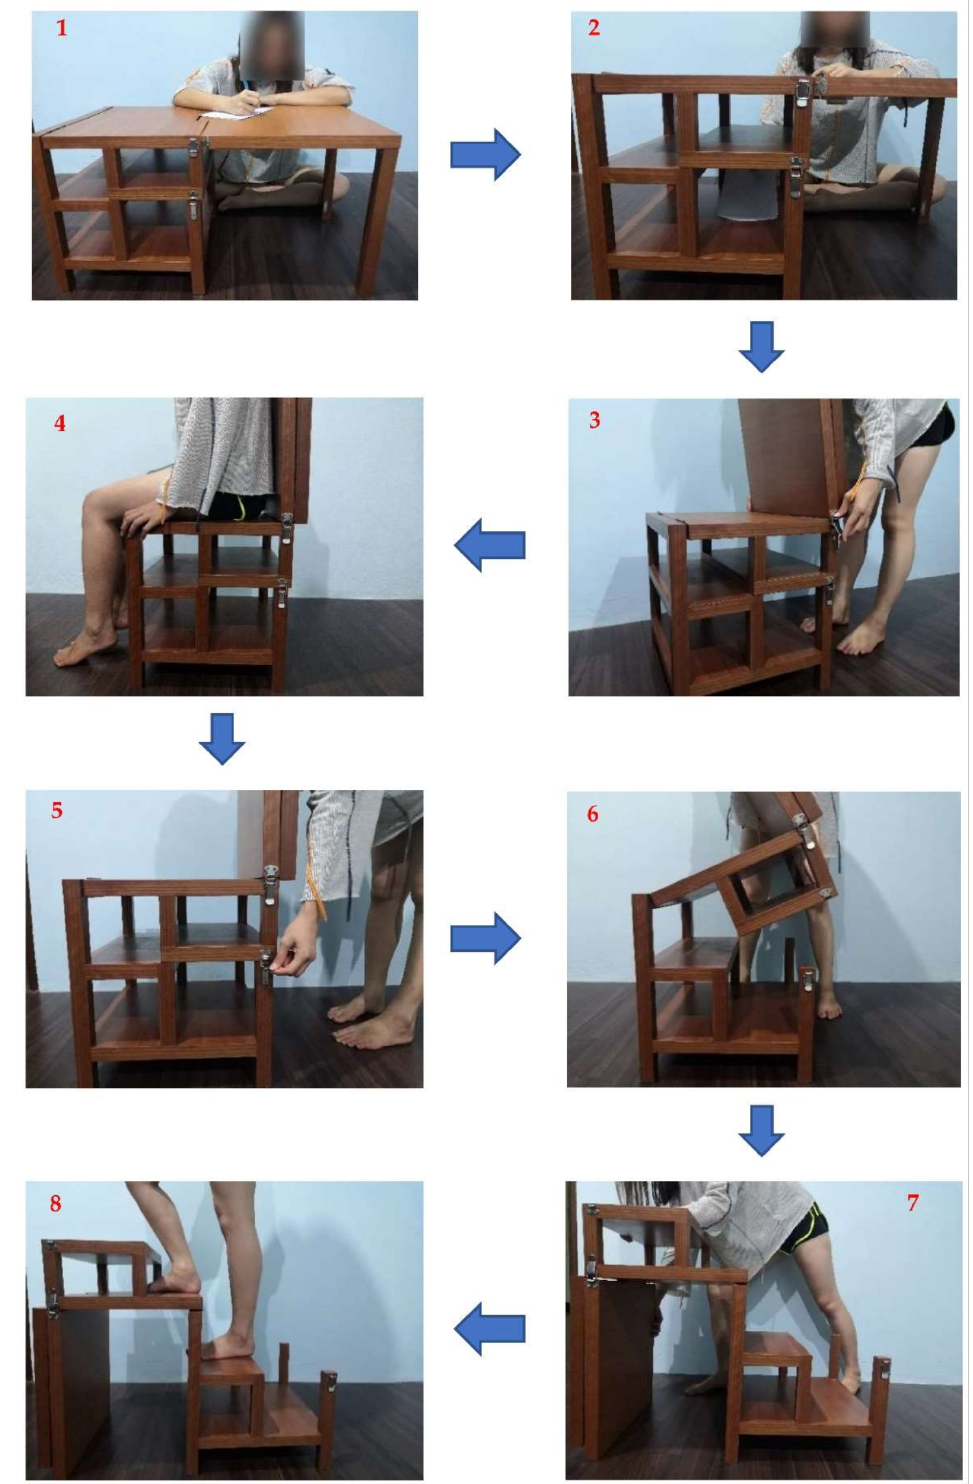
Figure 17. Step-by-step operation for the space-saving multipurpose